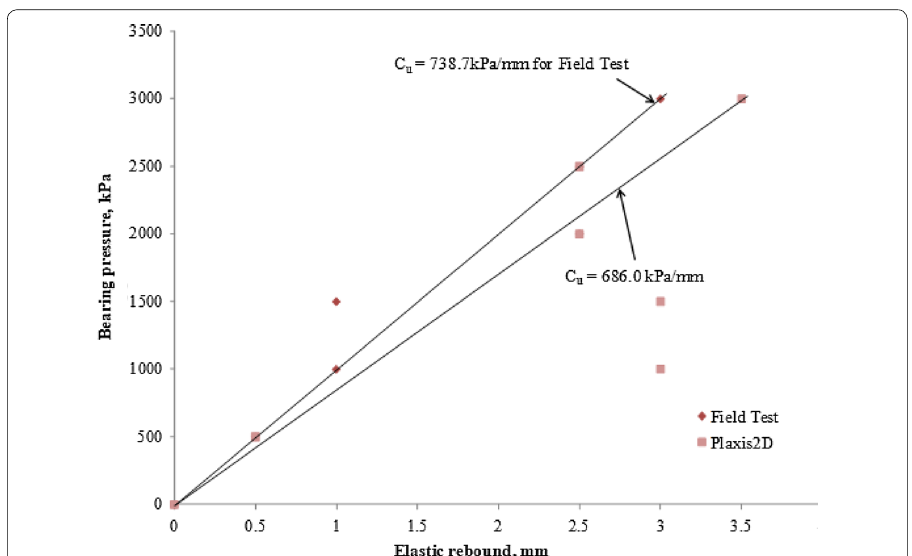
Fig. 18 Bearing pressure vs. elastic rebound for 60 cm plate size